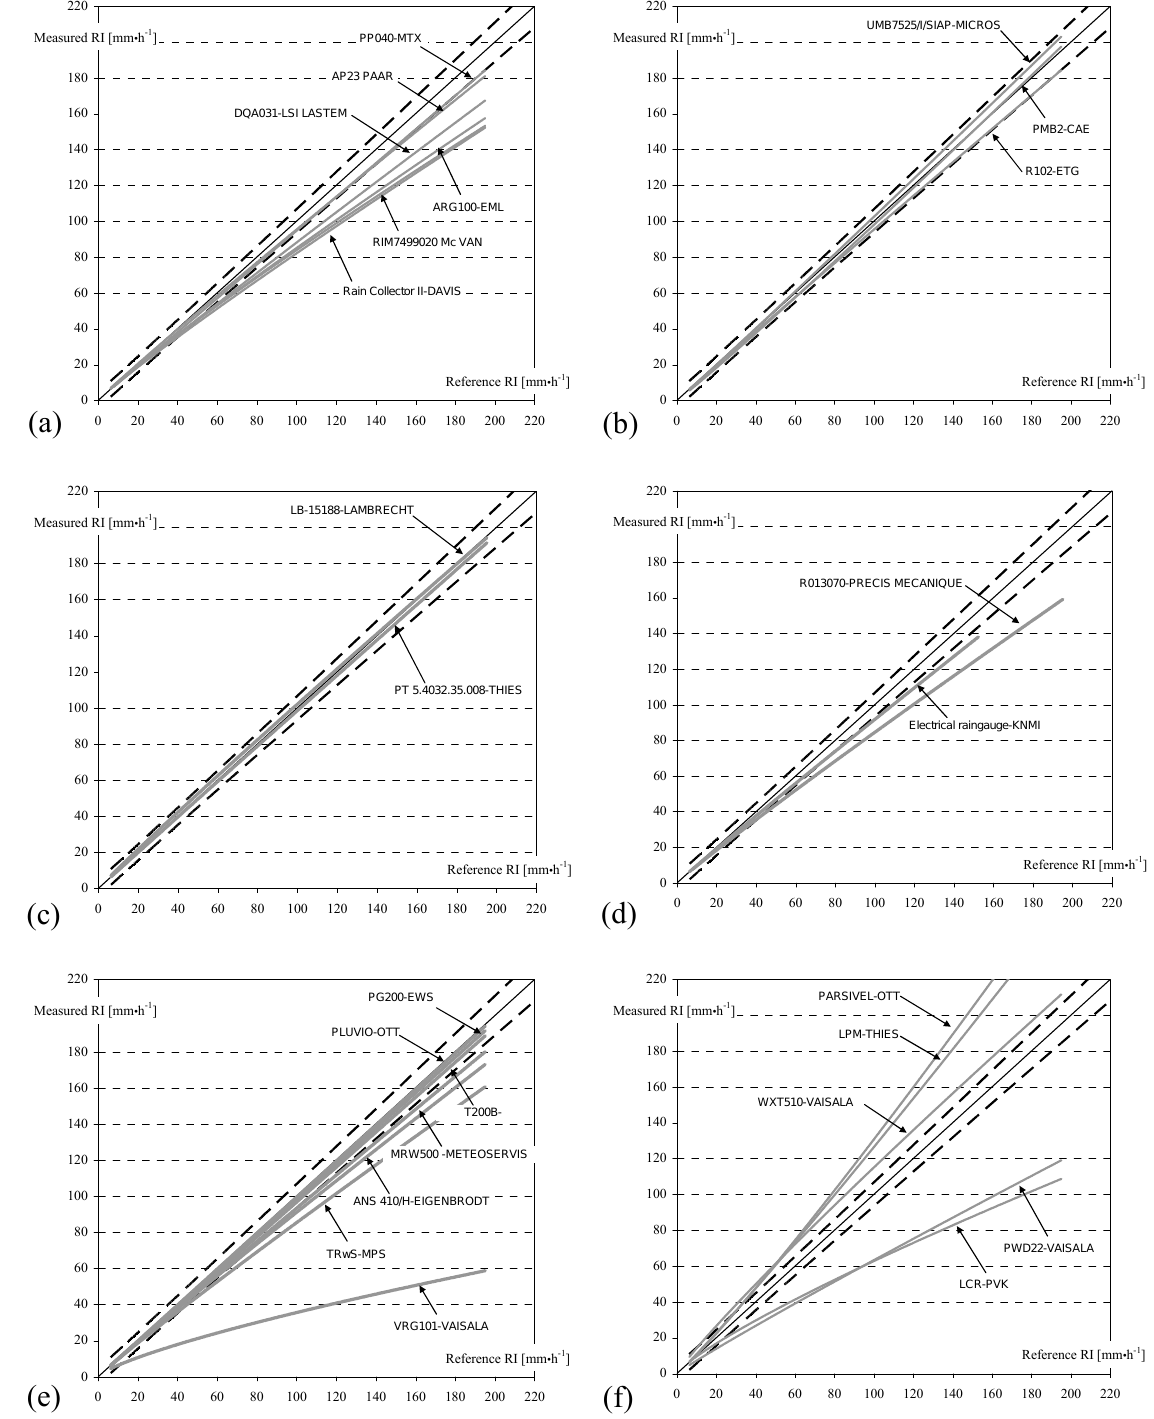
Fig. 4 : Comparison between the measured and reference rainfall intensity for various classes of rain gauges: non corrected TBRs (a), software corrected TBRs (b), pulse corrected TBRs (c), mechanically corrected TBRs or level gauges (d), weighing gauges (e) and gauges based on other measuring principles (f).